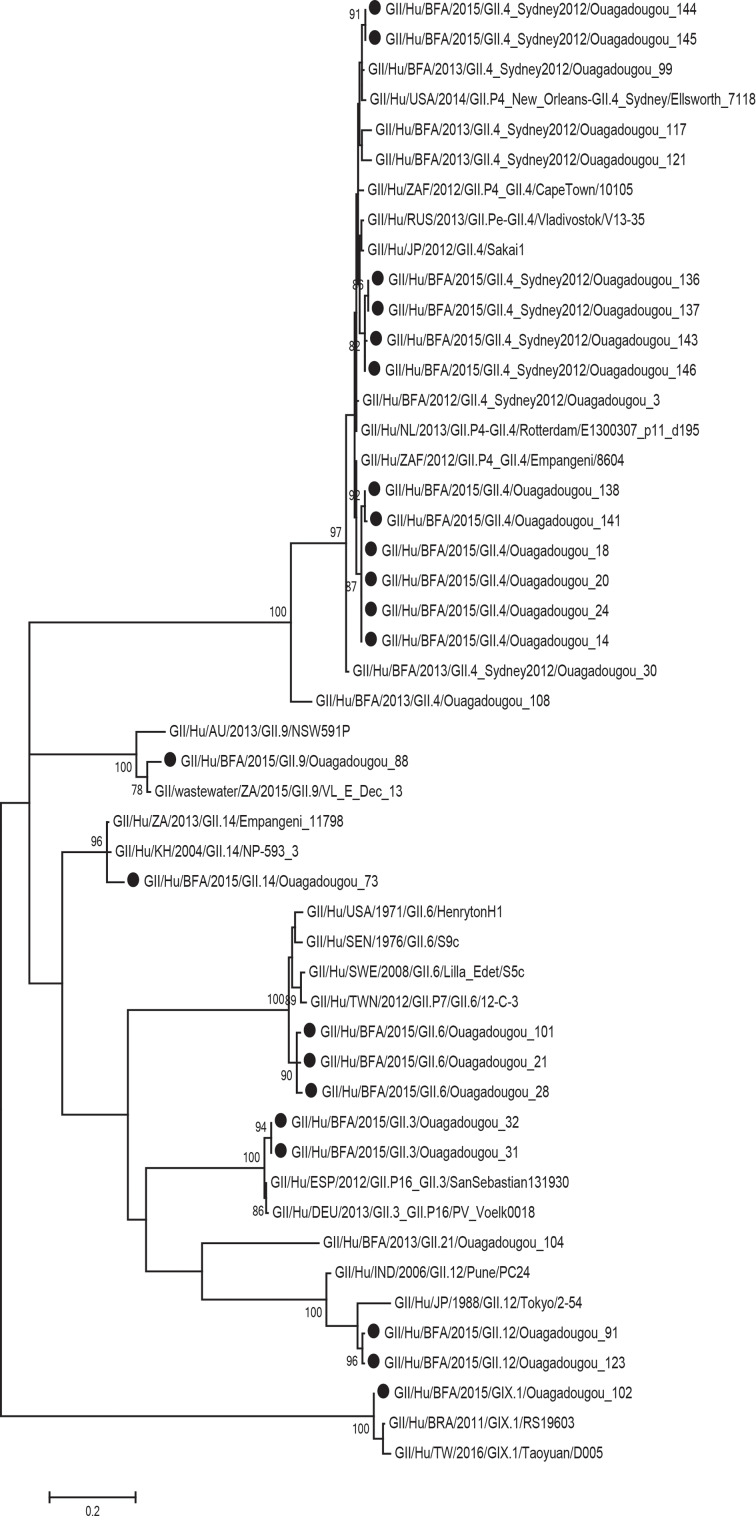
Phylogenetic analysis of the N-terminal and shell region (nt 1-272; ORF2) of norovirus genogroup II and IX strains in Burkina Faso January–December 2015. The tree contains most similar norovirus strains found on GenBank and norovirus strains from Burkina Faso 2013. The norovirus strains from this study are marked with filled circles. Scale bars represent the number of substitutions per site and bootstrap values are shown at branch nodes (values <70% are not shown).